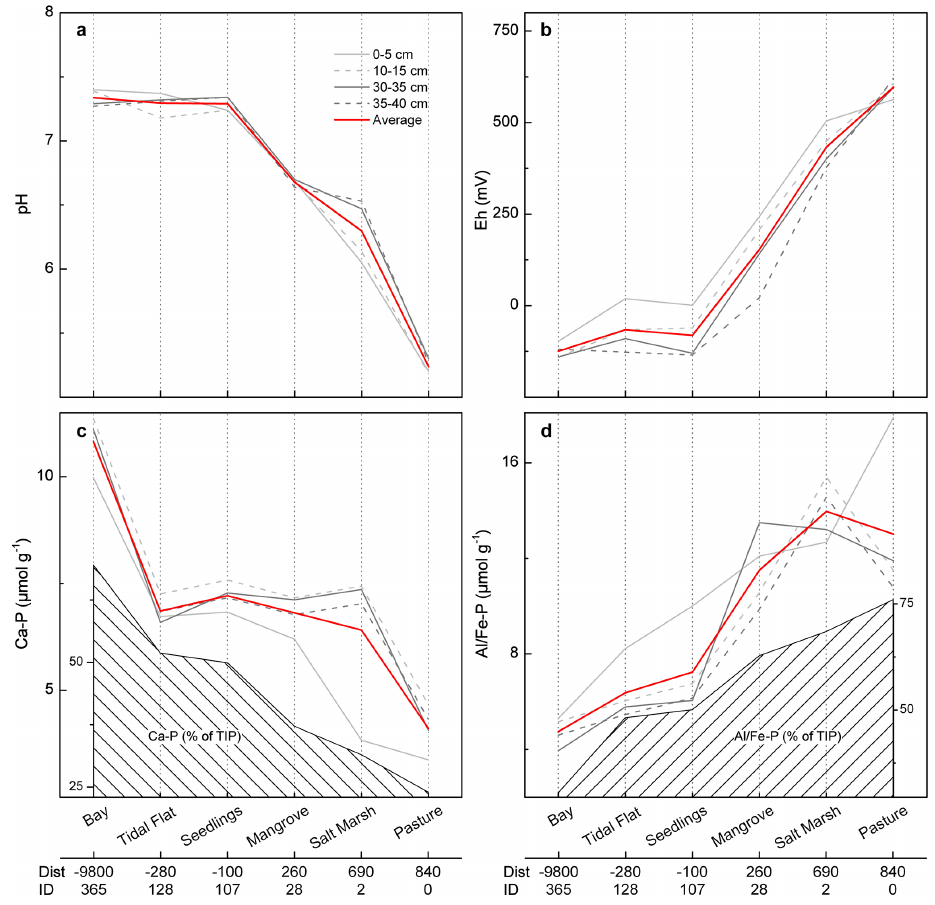
Figure 2. Physical–chemical sediment characteristics – (a) : pH; (b) : Eh – and sediment phosphorus fractions – (c) : Ca-P; (d) : Al / Fe-P – across ecosystems at the Firth of Thames. Each depth interval includes average values of several plots of each ecosystem across the entire site (all transects; see Table S1 for the number of averaged data and their values). Mean values of all depth intervals (112 samples) are also shown for each parameter. Mean fraction concentrations in % of total inorganic P (TIP) are given in (c) and (d) ; x axis labels include mean distance (Dist, metres, mangrove seaward margin is set as zero) and mean inundation durations (ID; daysyr − 1 ); r and p values for correlations among these parameters are given in Table